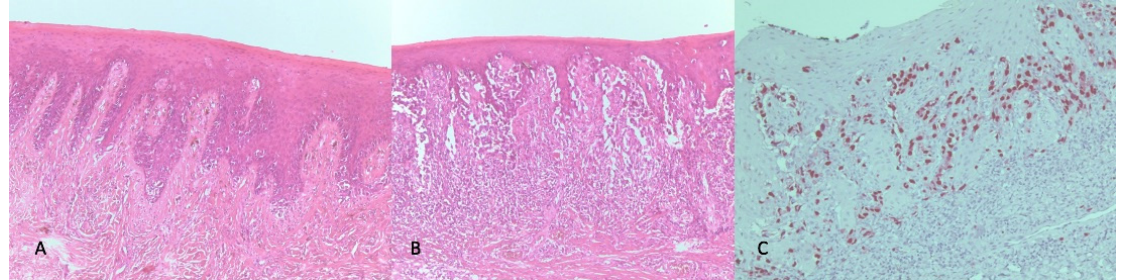
Figure 2. Histopathological images of the biopsied melanocytic lesion of the palate. ( A ) Hematoxylin–eosin staining 50× with evidence of lentiginous junctional melanocyte; ( B ) Hematoxylin–eosin staining 100× with evidence of atypical epi- thelioid cells; ( C ) Neoplastic cells highlighted at 100× with SOX-10.